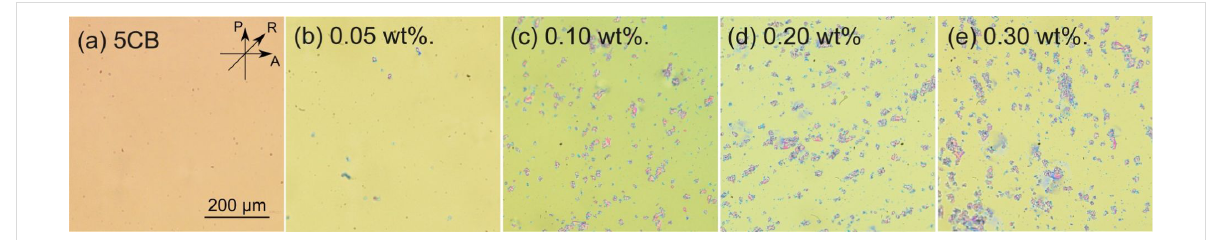
Figure 3: Liquid crystal textures of 5CB doped with graphene oxide flakes, captured at 23 °C. The optical polarizing images were taken in planar aligned cells for: a) the pure 5CB and 5CB-GO suspensions at concentration of b) 0.05 wt %, c) 0.1 wt %, d) 0.2 wt %, and e) 0.3 wt %.